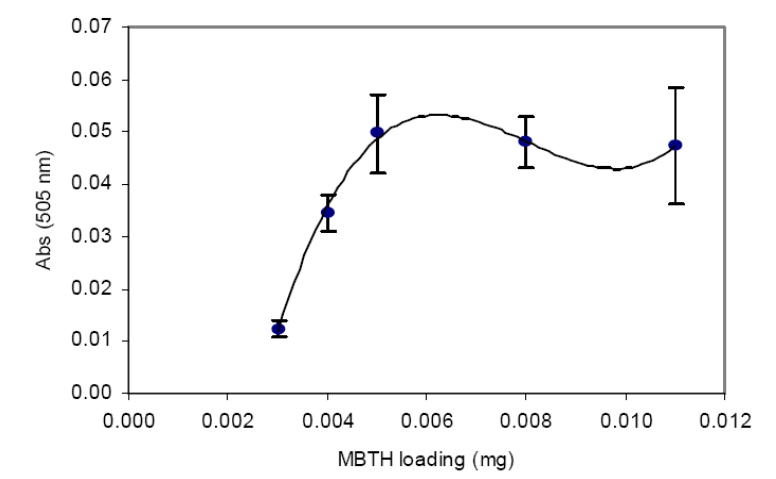
Figure 7 . The effect of the MBTH loading on the biosensor response with catechol concentration fixed at 6.5 mM in phosphate buffer pH 6.0.